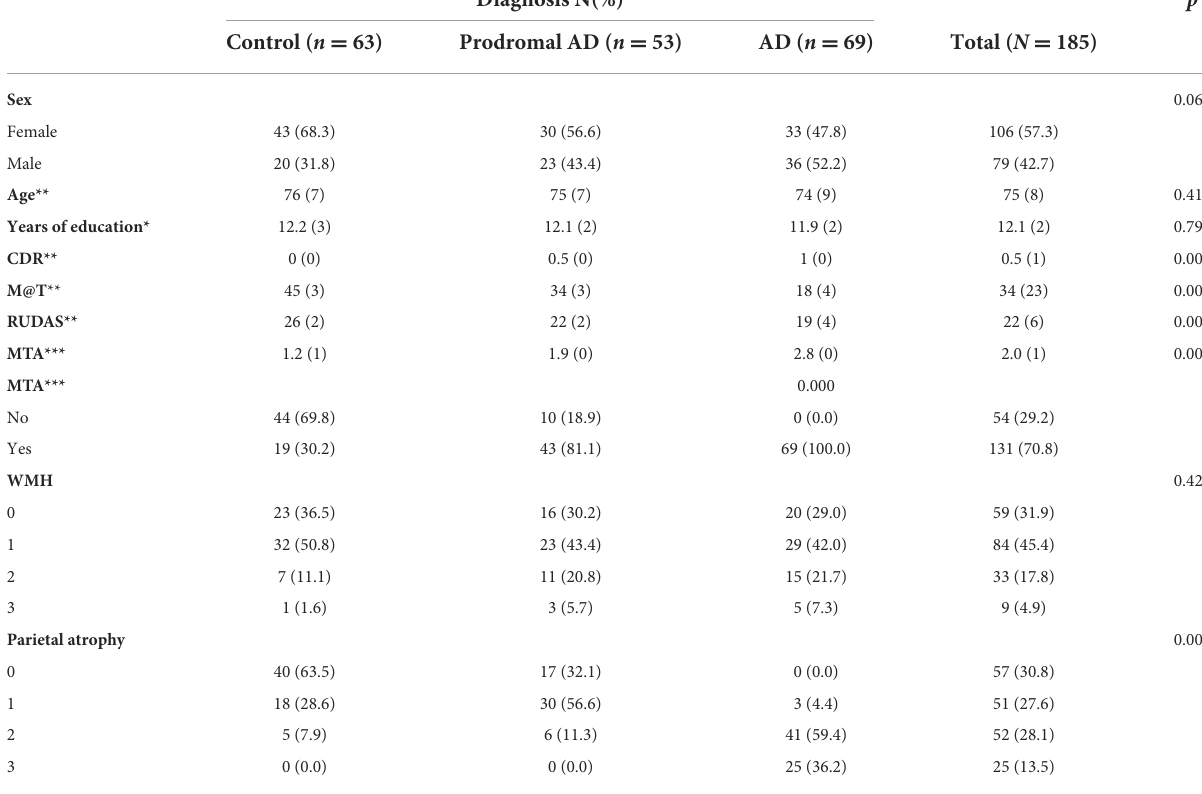
TABLE 1 Demographic characteristics and different imaging scores for patients with AD, MCI, or